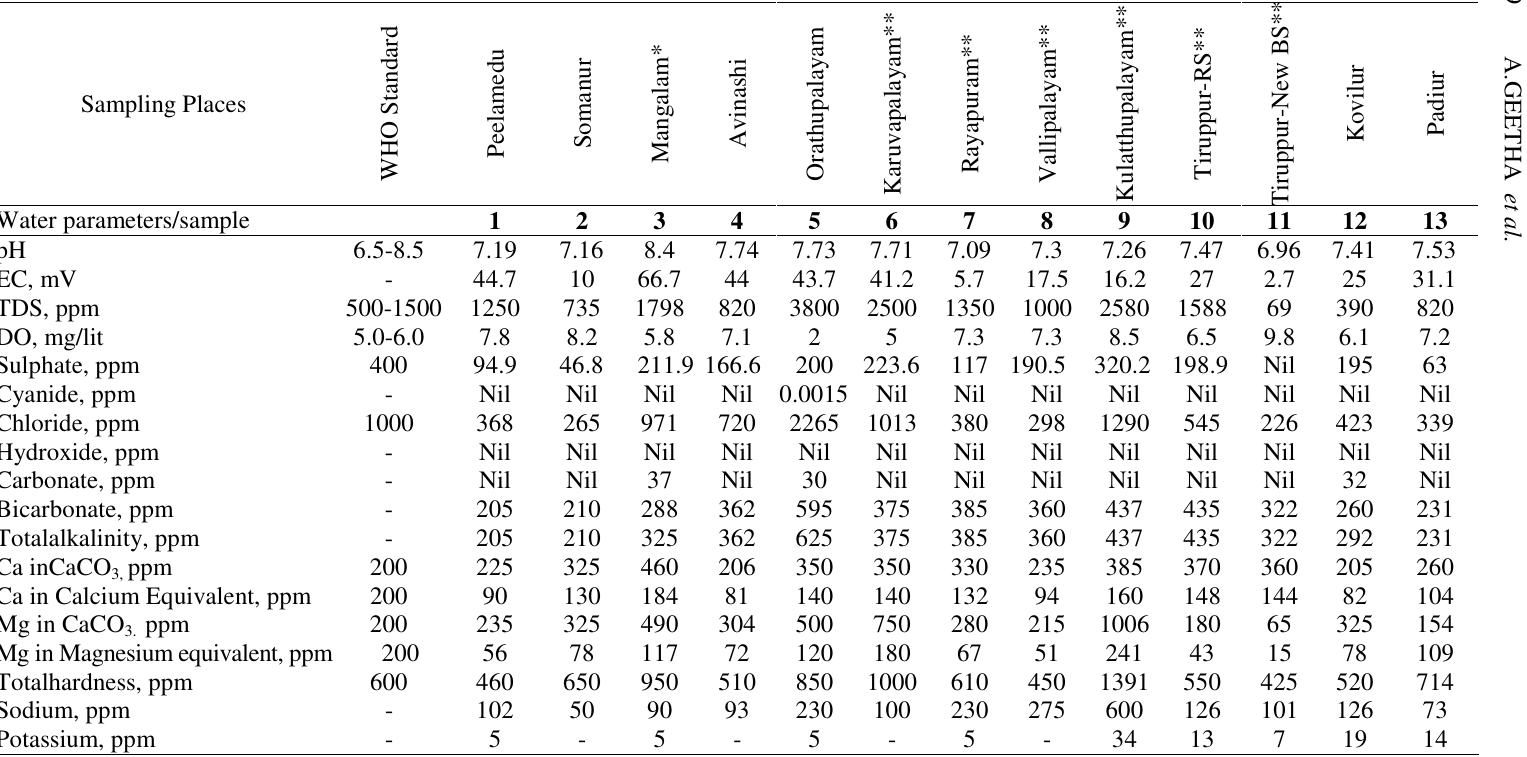
Table 1. Major physical and chemical water quality parameters of various water samples collected in and around Tiruppur